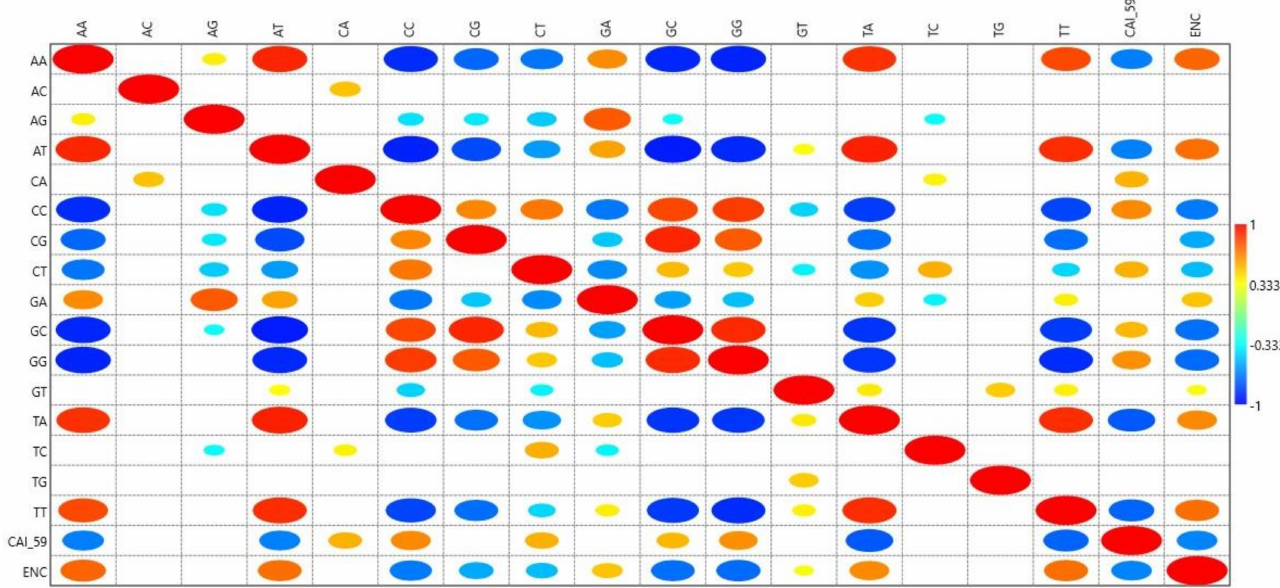
Figure 4. Mirror image plot depicting the correlation between CAI-59 and 16 dinucleotides. A bigger-sized eclipse described a higher Pearson’s correlation coefficient (r) value, and vice versa. The red color shows a positive correlation, while blue indicates a negative correlation. Empty boxes show an insignificant